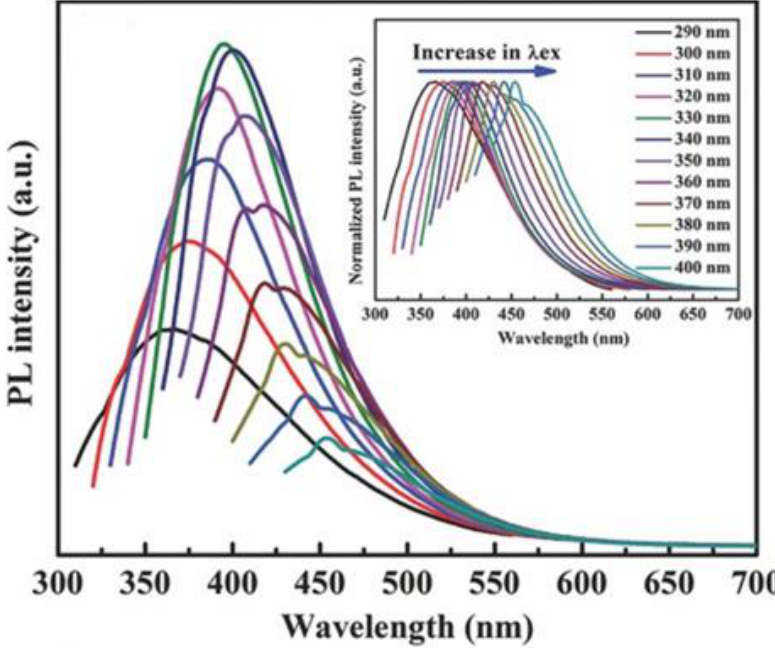
Figure 3. Photoluminescence (PL) of h-BN quantum dots showing excitation-dependent emission. The inset plot shows the corresponding normalized PL spectra [36]. Reproduced with permission.